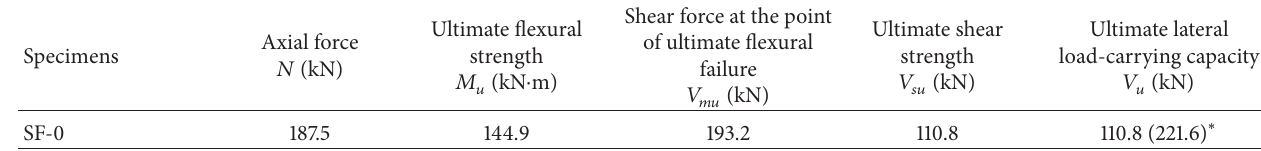
Table 4: The load-carrying capacity of the columns calculated according to JBDPA [3].